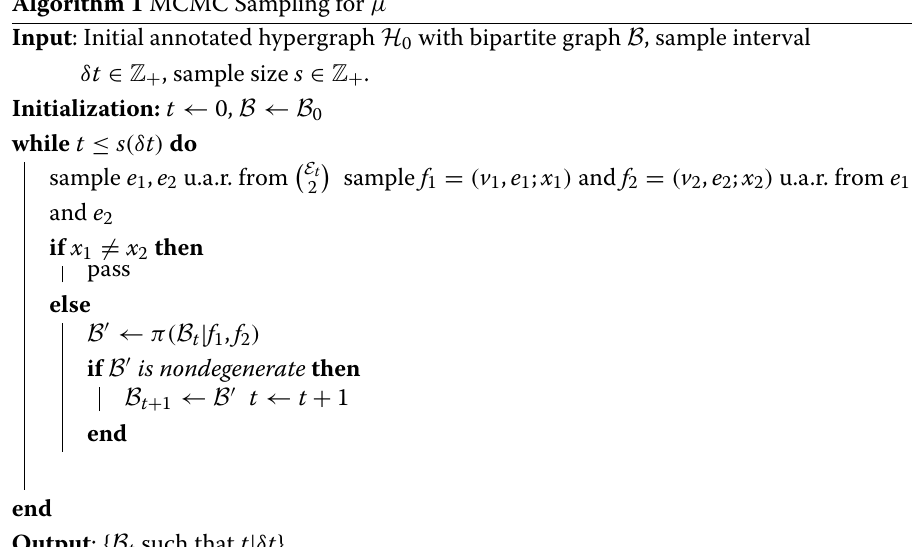
Algorithm 1 MCMC Sampling for